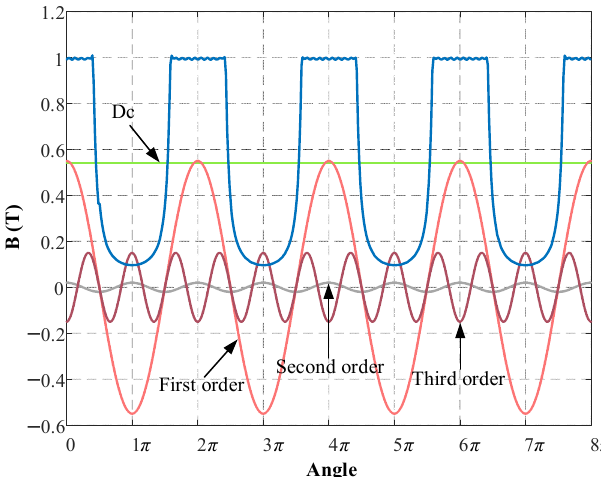
Figure 8. Air gap rate permeance waveform and each component.